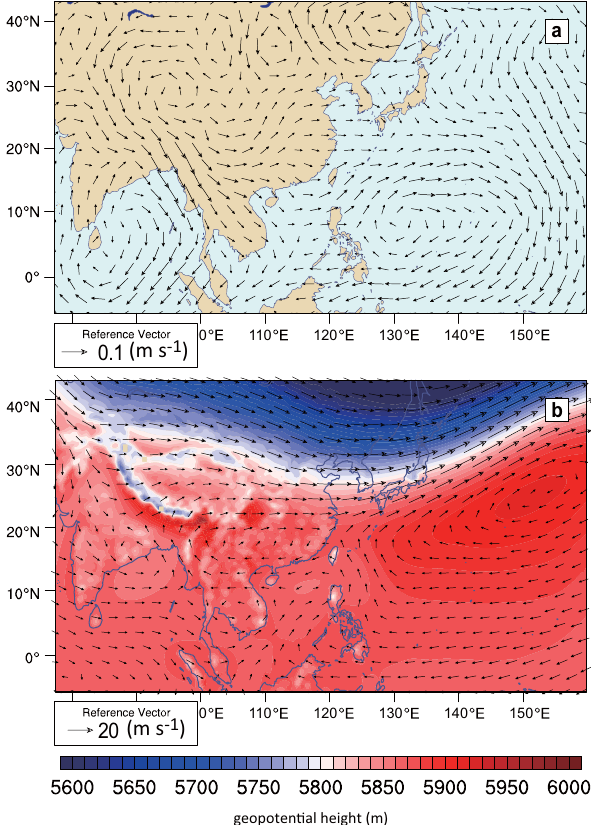
plies that the forecast of PWG is closer to ECMWF analysis Figure 8. (a) Mean differences of analysis wind field at 500hPa between PWG and PNG and (b) the mean of wind (vector) and geopotential height (shading) of PNG at